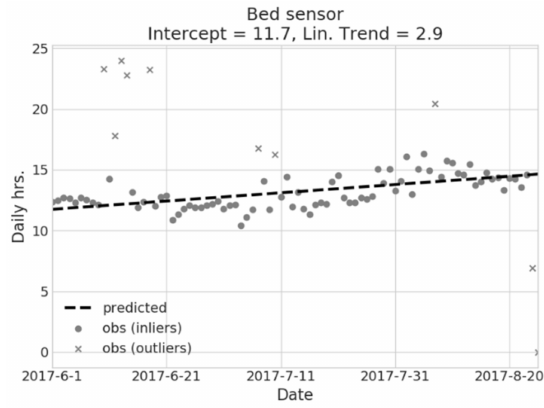
Figure 3. Example of the BEM model from a GLM regression on the bed usage hours during the night. Usage prediction is shown, as are detected anomalies